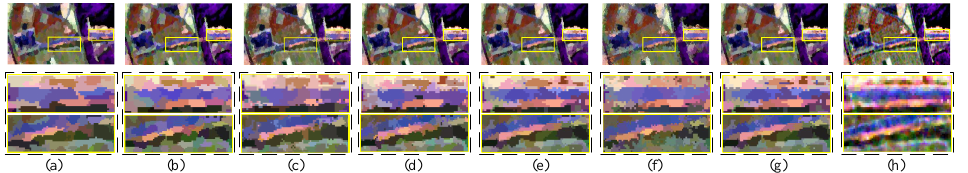
Figure 16. Enlarged region B of the AIRSAR data set. ( a ) POL-SLIC. ( b ) POL-LSC. ( c ) POL-HLT. (a) ( d ) WS. ( e ) HAWS. ( f ) HAGS. ( g ) The proposed HCI. ( h ) Pauli-RGB image.